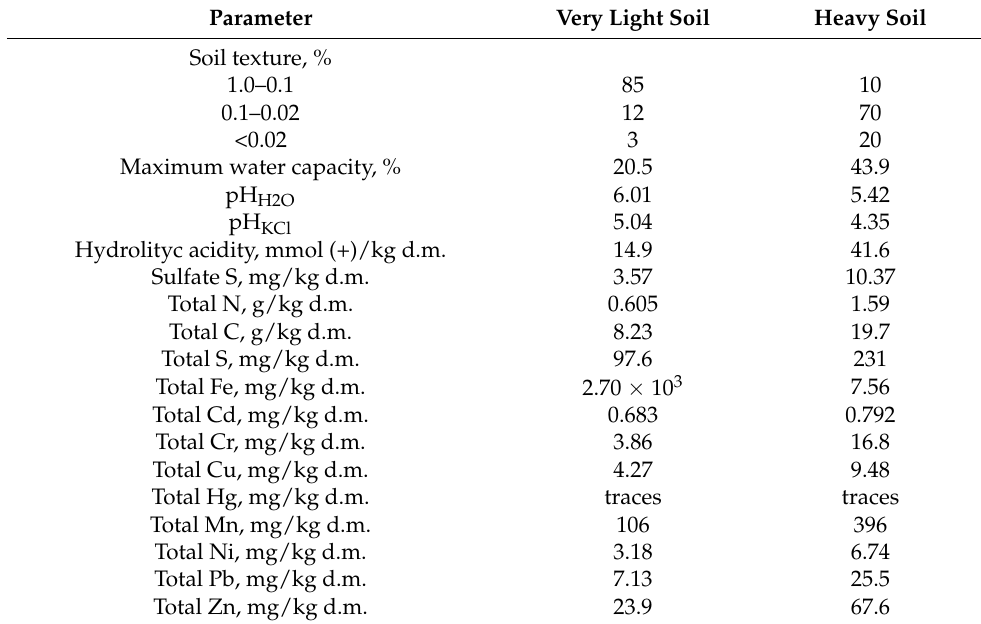
Table 1. Selected properties of soil material before establishing the